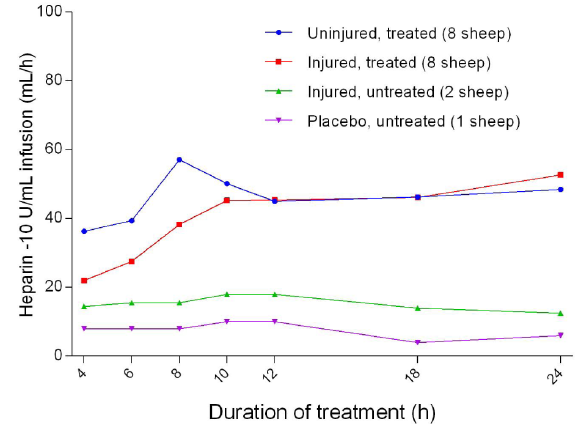
Figure 44. Heparin (10 U/mL) infusion rate (Mean ± SD, error bars not shown) in smoke and non-smoke injured sheep that received extracorporeal life support as compared to that in untreated controls.